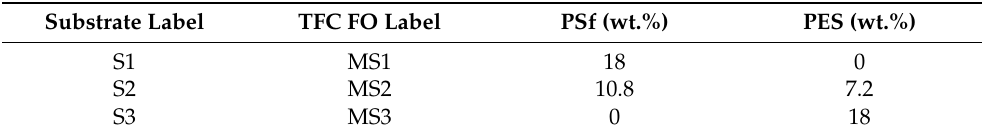
Table 1. Polymers compositions of the support membranes dissolved in